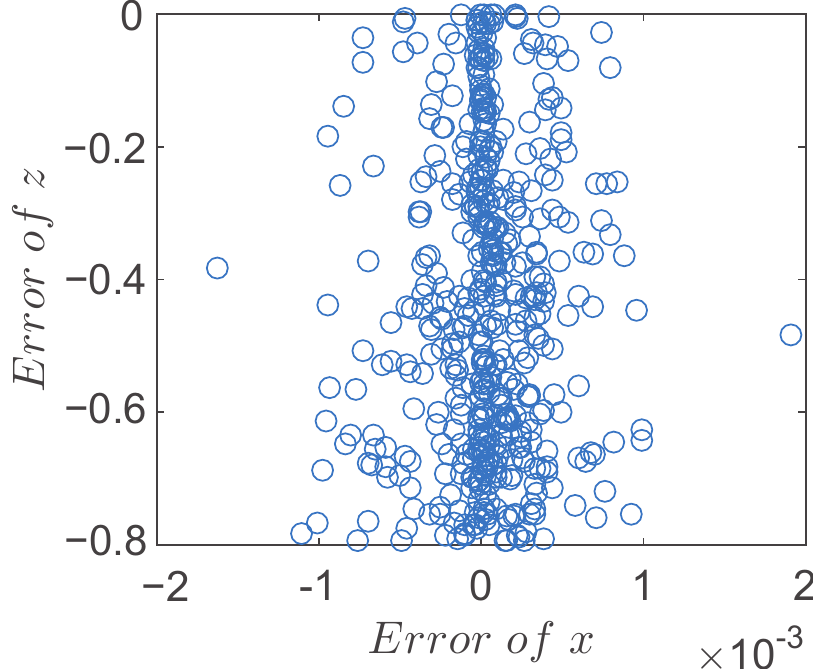
Figure 14. Curve of Monte-Carlo results on the x and z axes.